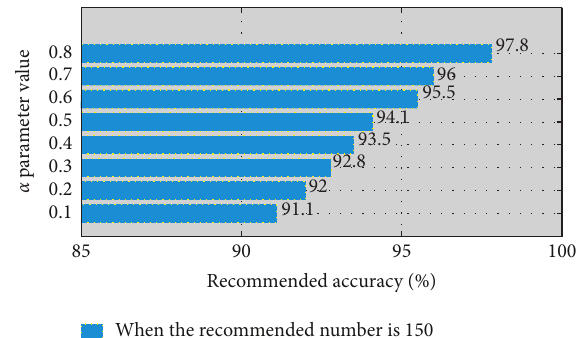
Figure 8: The change of recommended accuracy after case-based reasoning under different α parameters.